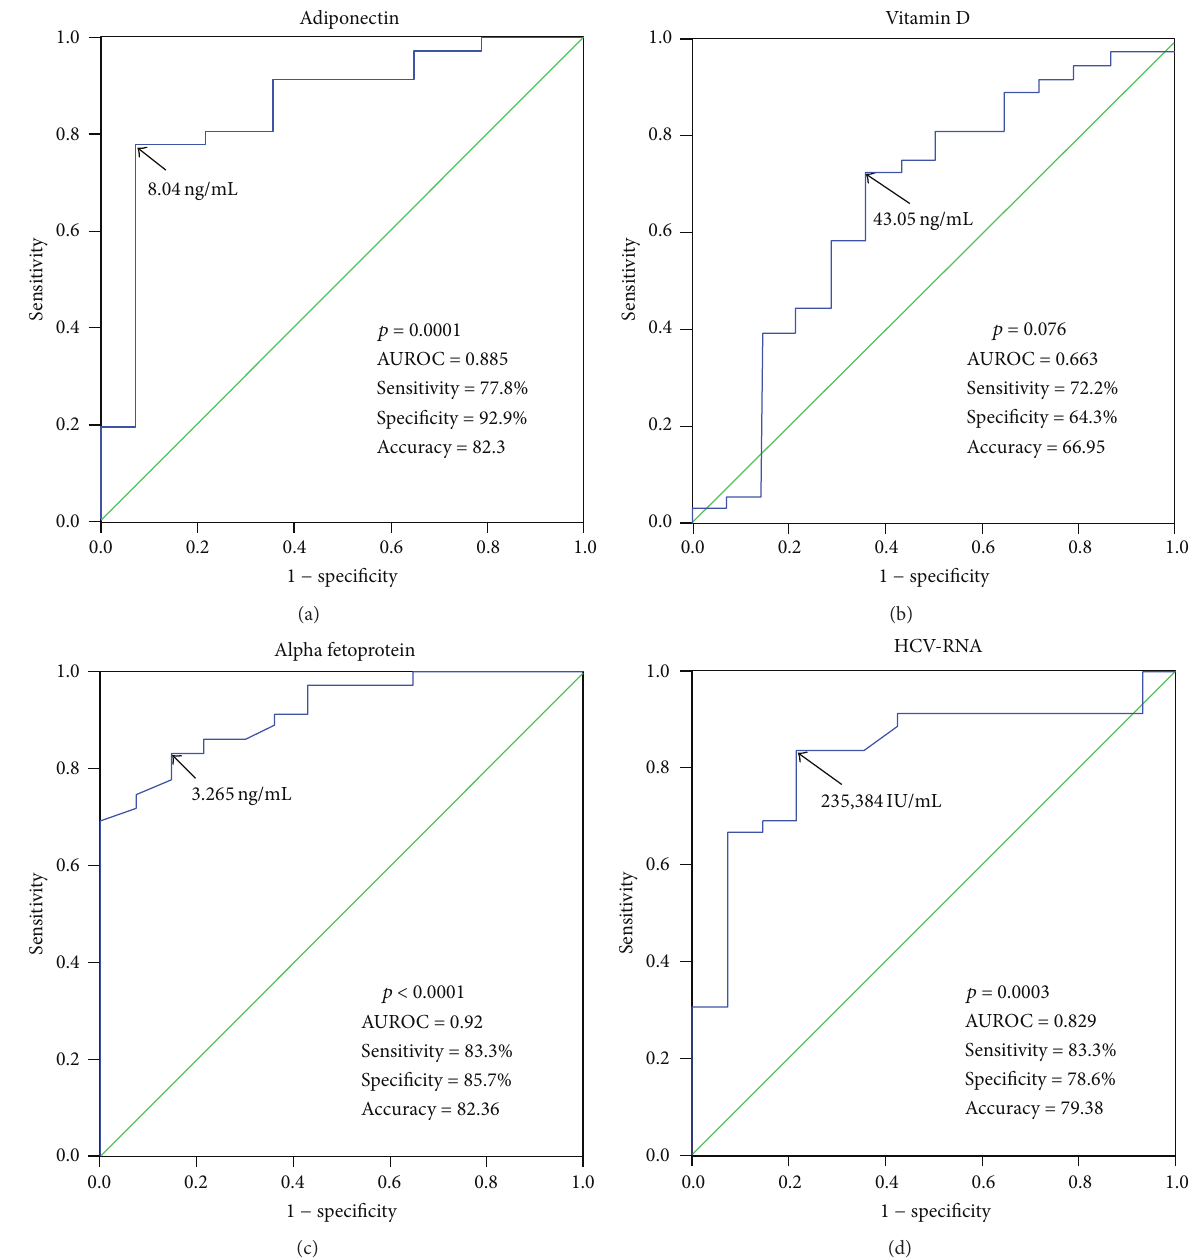
Figure3:Diagnosticperformanceofpretreatmentparametersfordifferentiationbetweenrespondersandnonresponders.Receiver-operating characteristic (ROC) curves of (a) adiponectin, (b) vitamin D, (c) AFP, and (d) HCV-RNA level for differentiation between responders and nonresponders. The arrows indicate the cutoff values. AUROC: area under